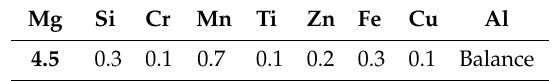
Table 2. Chemical composition of AW5083 aluminum alloy (in wt.%).